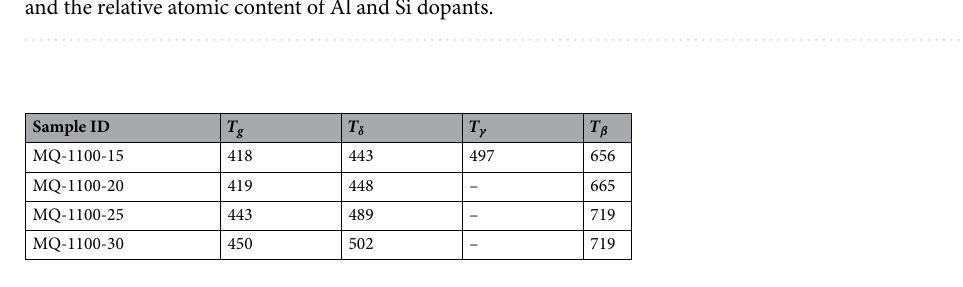
Table 2. Temperatures of glass transition T g and crystallizations ( T δ , T γ , T β ) assigned to β , δ and γ - Bi 2 O 3 ◦ phases. All values are given in